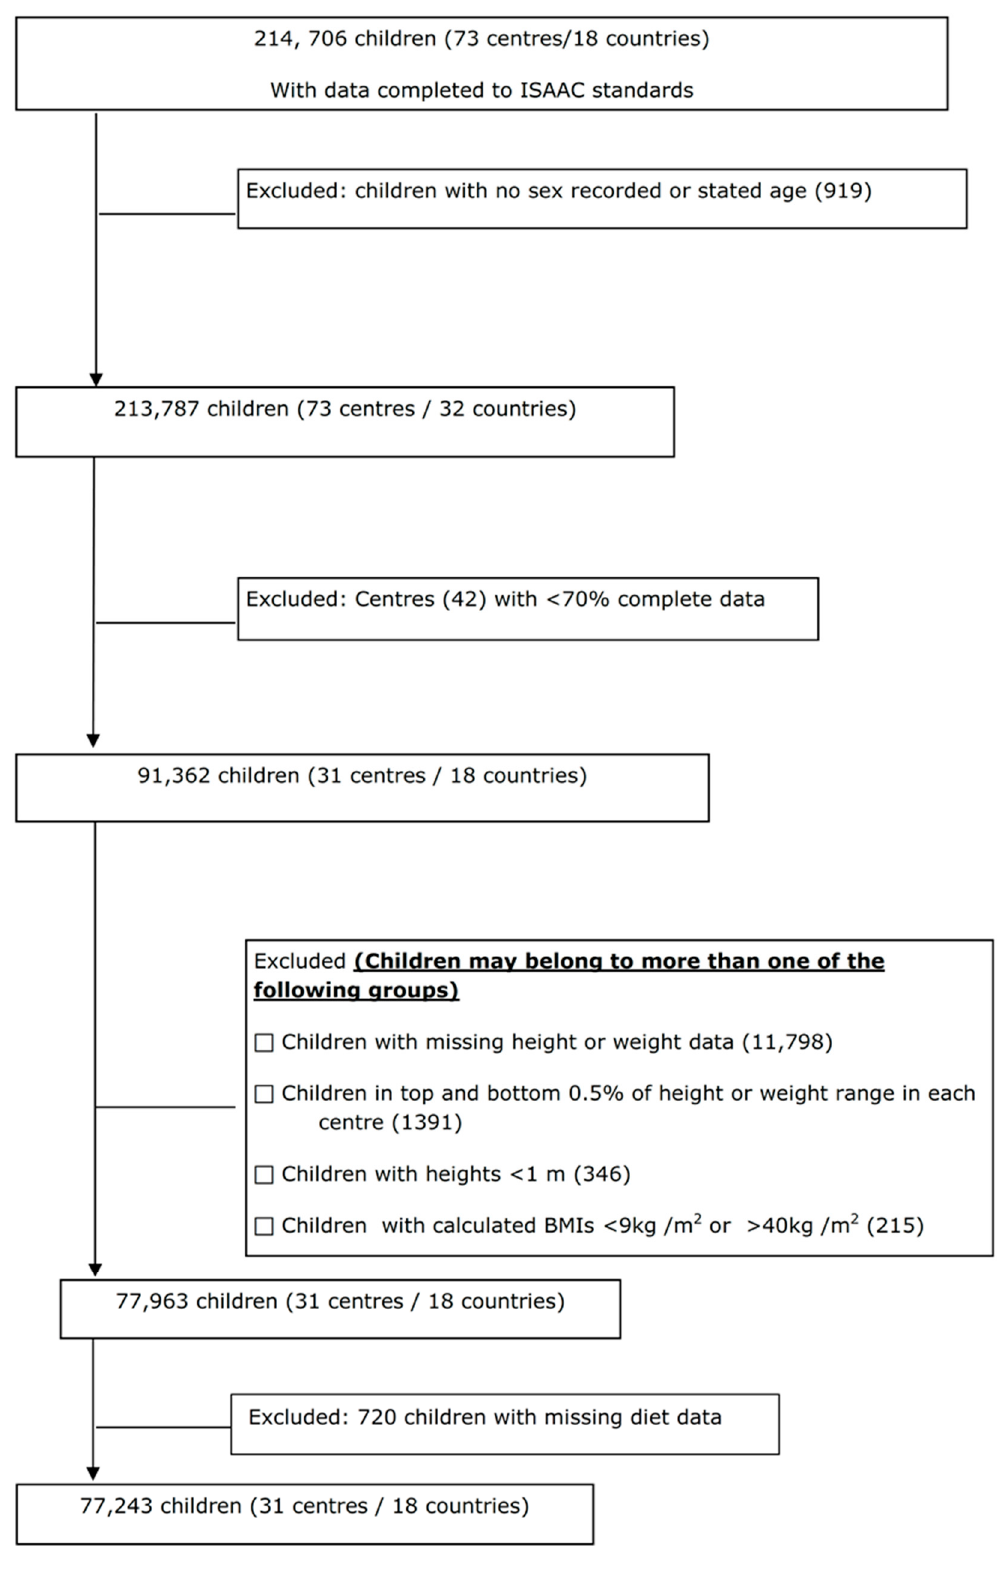
Figure 2. Flow of children through the study.